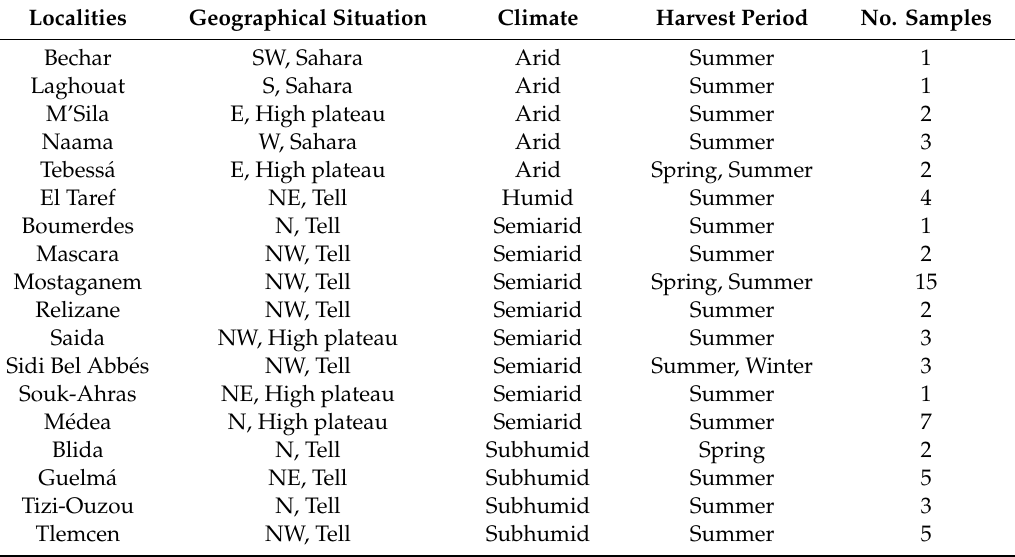
Table 1. Geographical origin of samples, climate, and harvest